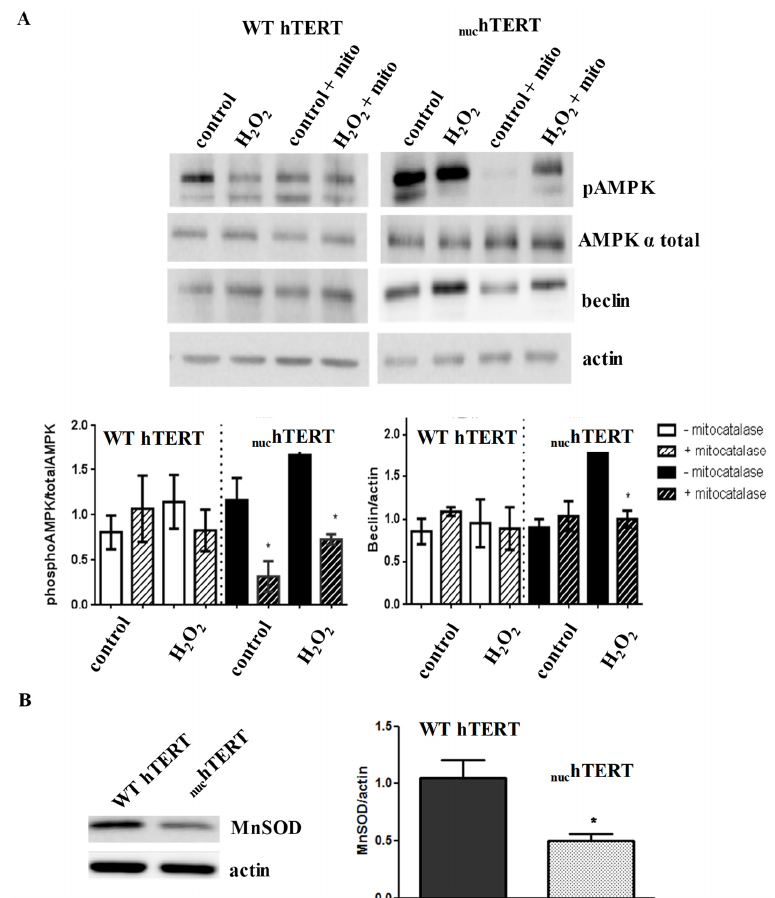
Figure 5. Expression of mitochondrially-targeted catalase blunts AMPK activation and autophagy in nuc hTERT-expressing cells. ( A ) WT hTERT and nuc hTERT cells were infected with an adenovirus expressing mitocatalase and 24h later cells were treated with H 2 O 2 for 60 min. Beclin and AMPK levels were evaluated through immunoblot analysis. Actin was used as loading control. Western blots are representative; graphs are the mean of four biological experiments ± SEM. Student t -test compared control untreated to control mitocatalase and so forth. Statistical significance was determined at a p value < 0.05 *. Protein extracts were taken from untreated WT hTERT and nuc hTERT cells. Actin was used to normalize data. The graph represents the mean of three independent experiments. Student t -test compared either cell type to the untreated samples. Statistical significance was determined at a p value < 0.05 *. ( B ) Levels of MnSOD were assayed by immunoblots in the cells and actin was used as loading control to normalize MnSOD amounts The graph represents the mean of three independent experiments; student t -test compared levels in WT to mutant cells. p value < 0.05